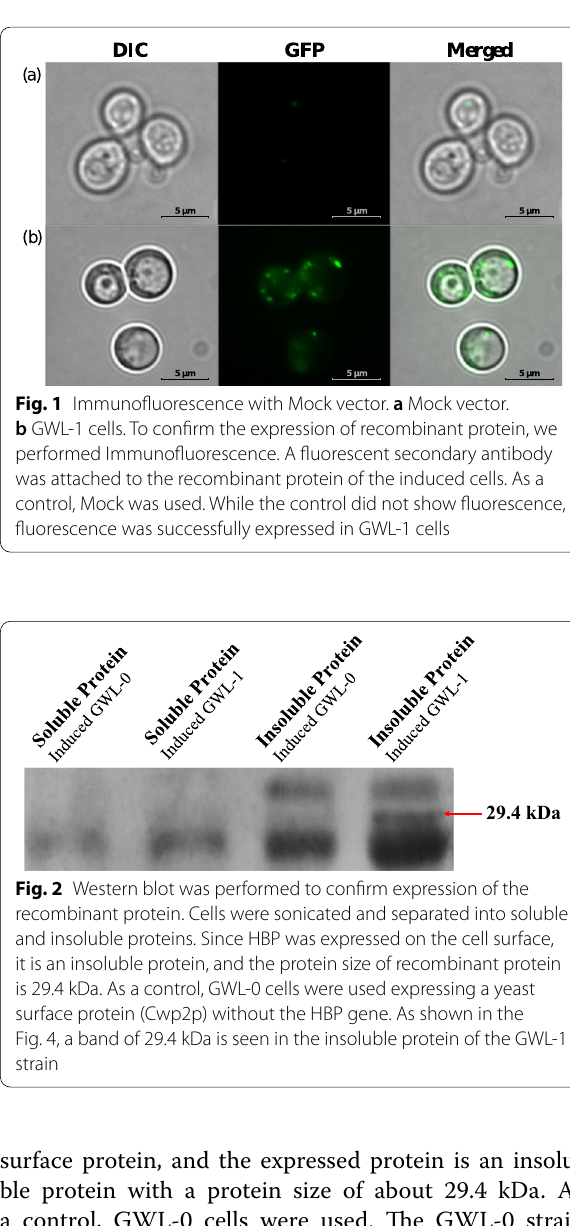
Fig. 2 Western blot was performed to confirm expression of the recombinant protein. Cells were sonicated and separated into soluble and insoluble proteins. Since HBP was expressed on the cell surface, it is an insoluble protein, and the protein size of recombinant protein is 29.4 kDa. As a control, GWL‑0 cells were used expressing a yeast surface protein (Cwp2p) without the HBP gene. As shown in the Fig. 4, a band of 29.4 kDa is seen in the insoluble protein of the GWL‑1